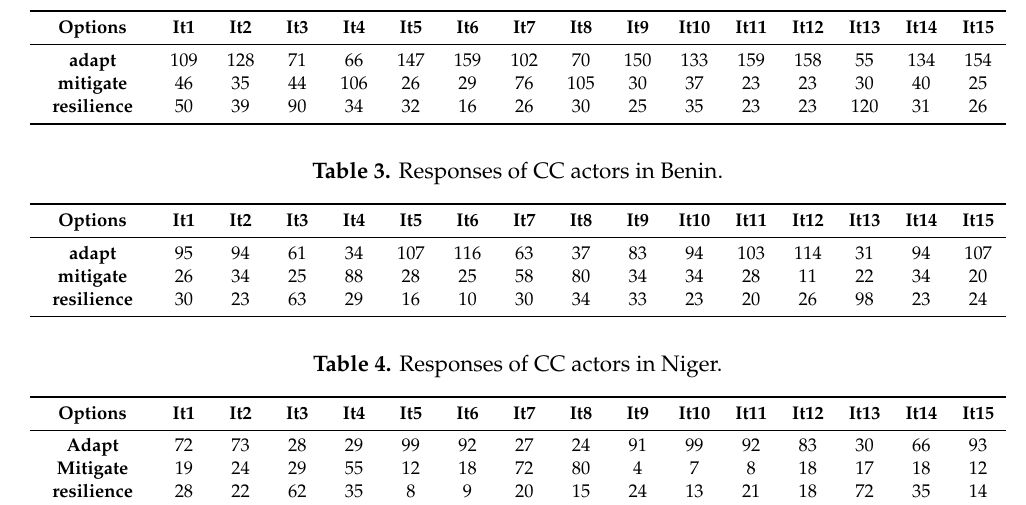
Table 2. Responses from CC actors in Nigeria.